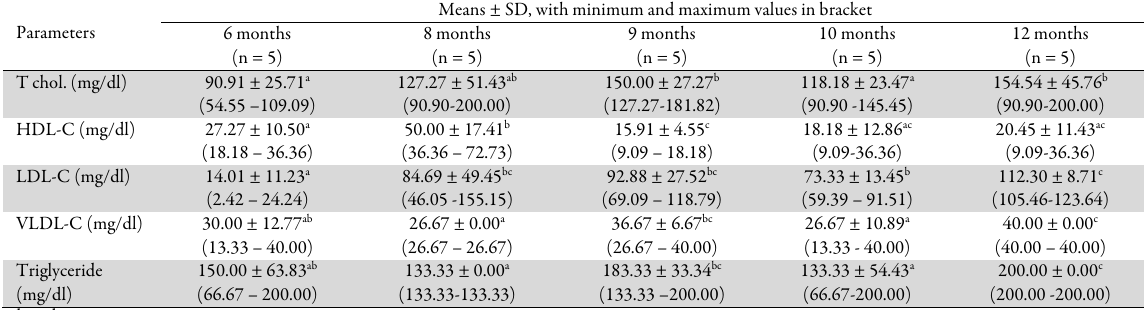
a,b,c,ab,ac Different superscripts in a row indicate significant differences across the groups (P < 0.05